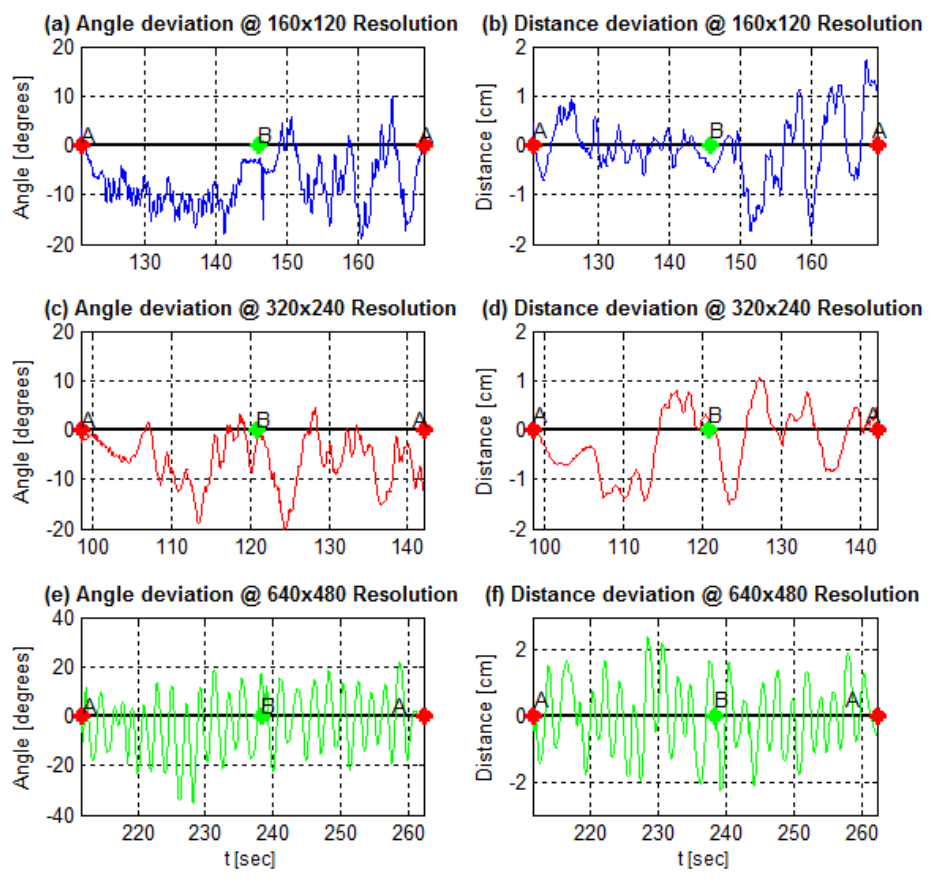
Figure 30. A lane cycle for each image